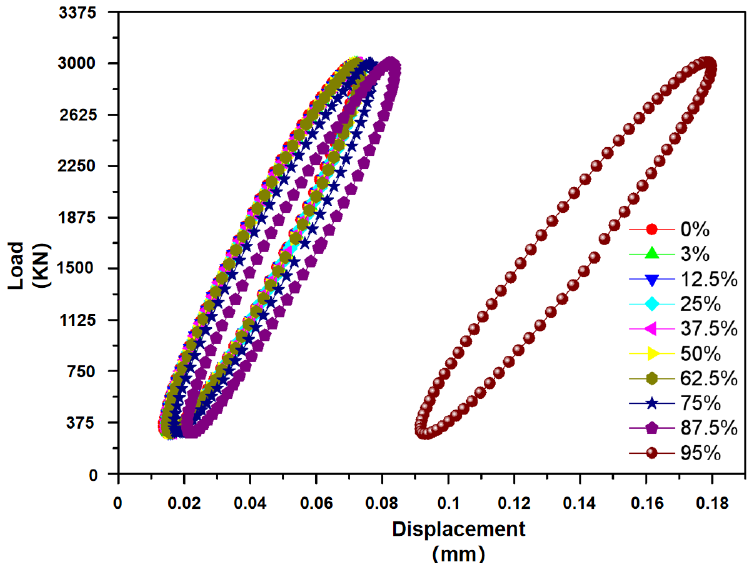
Figure 14. Load–displacement curve of high cycle fatigue.